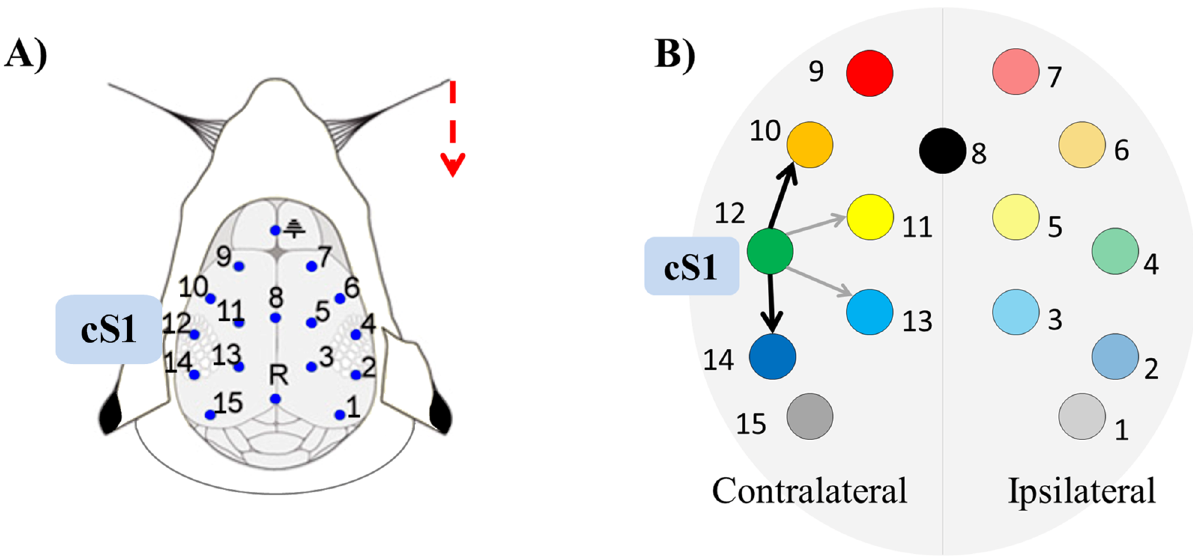
Fig 2. Benchmark EEG data: Recording setup and network of expected functional connections. A) Provides a schematic representation of the setup for epicranial recording. The dashed arrow in red represents the unilateral whisker stimulation. B) The diagram shows the expected behavior of the cortical network’s connections at early latencies after whisker stimulation. This is characterized by dominant total driving from contralateral primary somatosensory cortex (cS1, node 12) at latencies between 8 and 14 ms after stimulation. At peak driving the preferential directions of cS1 connections are expected to be found towards contralateral parietal (node 14) and more frontal cortex (node 10). Bright colors are used for nodes on the contralateral hemisphere to stimulation, while pale colors are used for the nodes on the ipsilateral